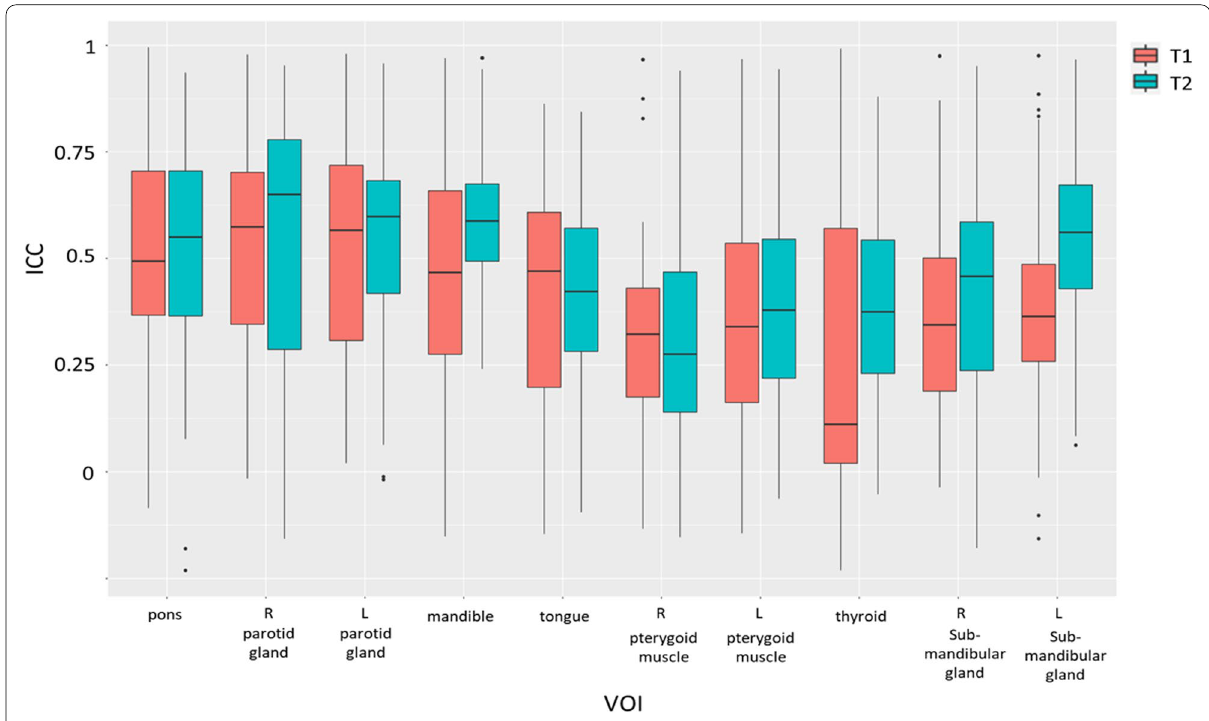
Fig. 2 Boxplots of ICC values in different tissue VOIs for both pulse sequences